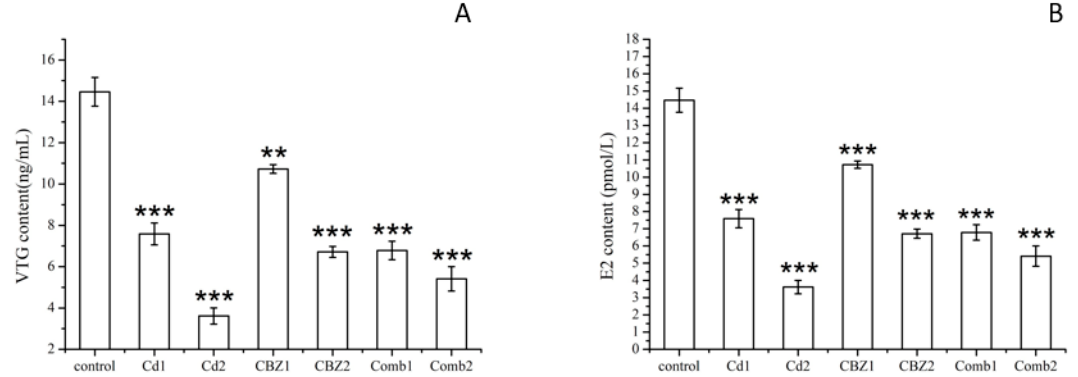
Figure 4. ( A ) Vitellogenin (VTG) content and ( B ) Estradiol (E2) content in female fish after ten -days of exposure to Cd, CBZ, and Cd + CBZ. The results of one-way ANOVA are indicated at the significance levels * p < 0.05, ** p < 0.01, and *** p < 0.001.